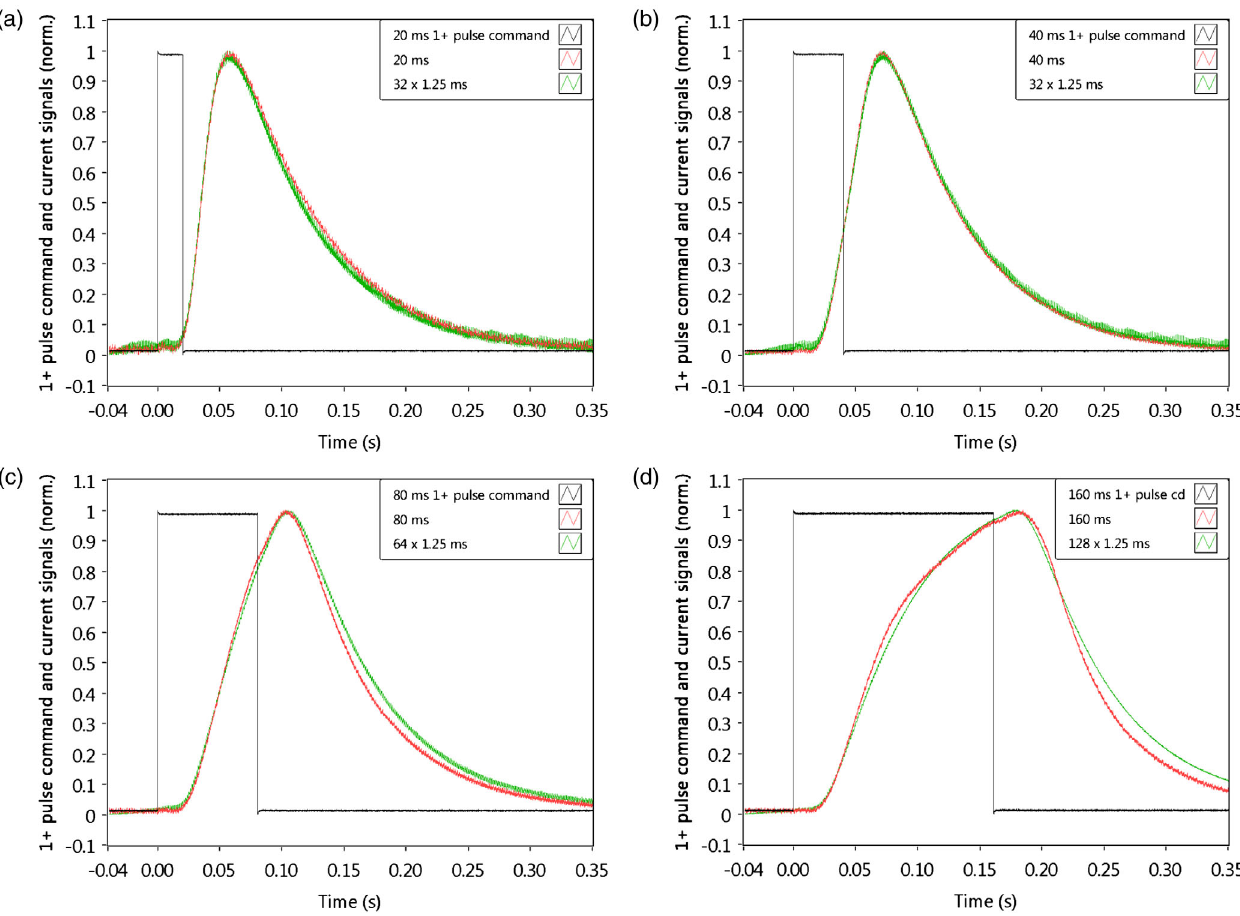
FIG. 9. N þ responses built from the duplication and sum of a 1.25 ms pulse response compared to measured N þ responses for 20 (a), 40 (b), 80 (c), and 160 ms (d) pulse durations. The curves are normalized in such a way that the maximum intensity is set to